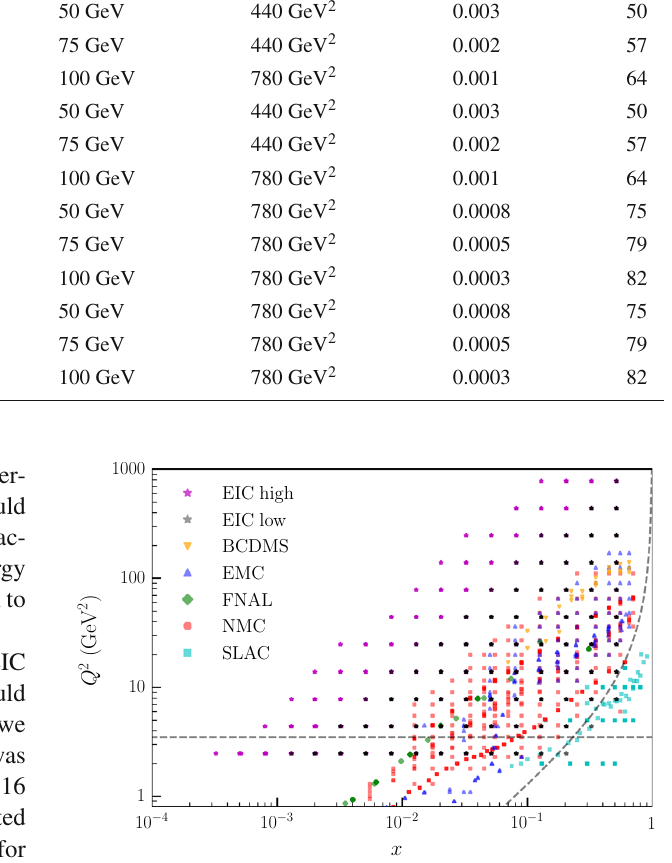
E A / A energy, the maximum and minimum values of Q 2 and x of the pseudo-data, respectively, and the number of pseudo- data points N dat . Here we restrict ourselves again to the inclu- sive structure functions and do not include EIC pseudo-data on charm structure